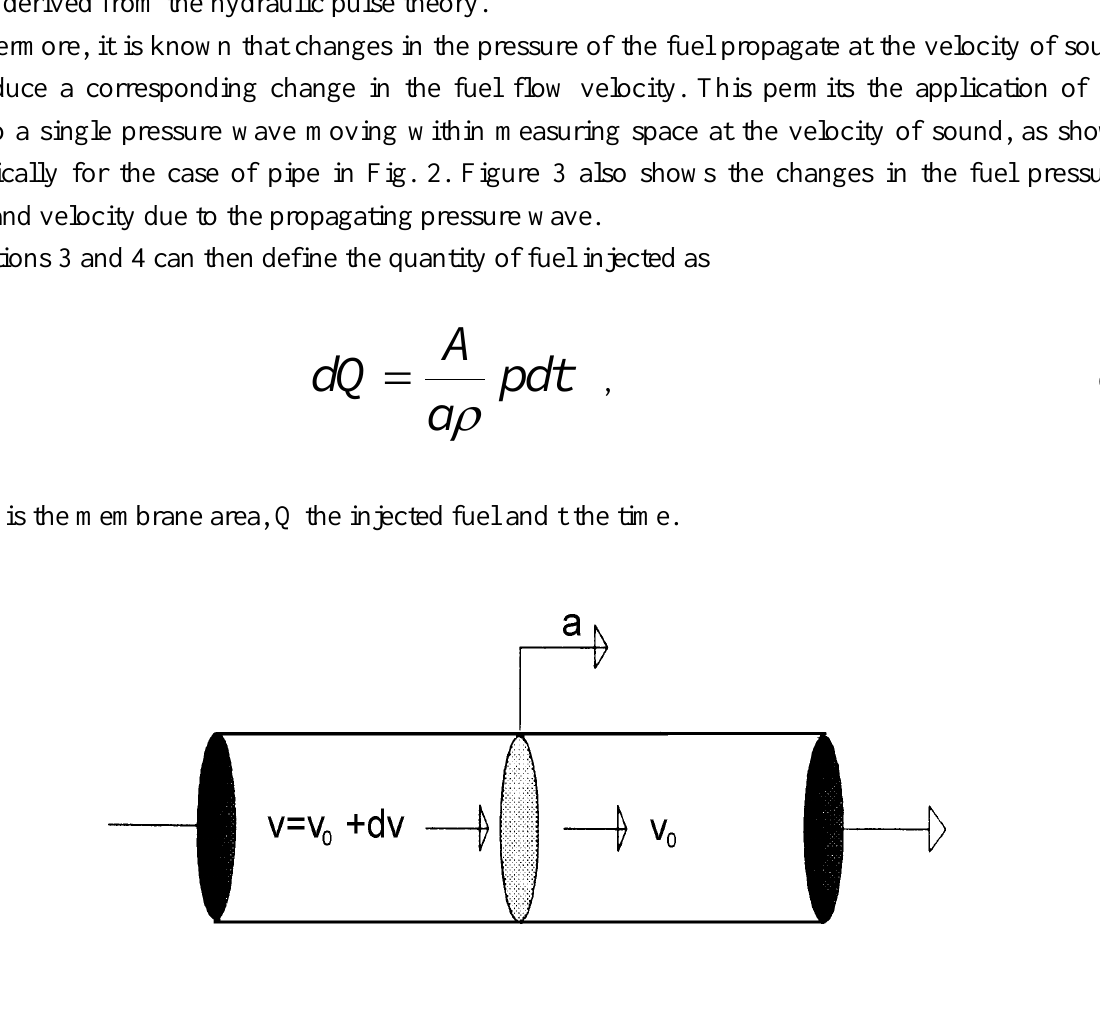
Figure 2. The flow velocity change due to the propagating pressure wave travelling at the speed of sound.